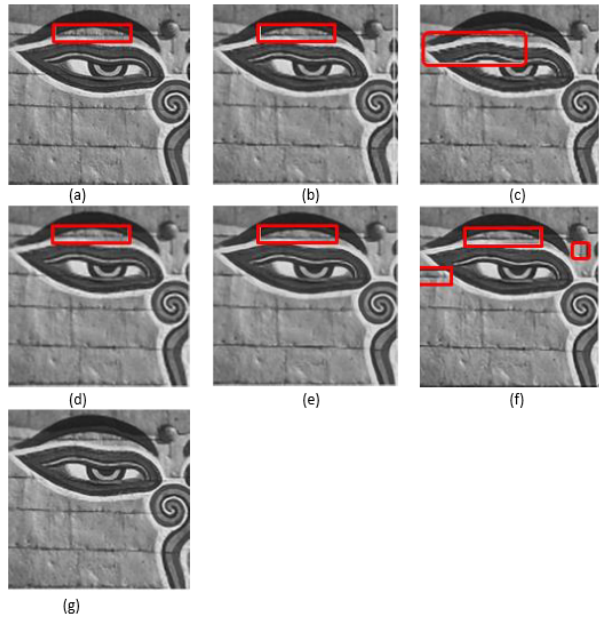
Two-time reconstructed image Artwall using the six SR methods. (a) Input test image. (b) FCME. (c) NARM. (d) CSFI. (e) NeedFS. (f) IUIE. (g) Our method.